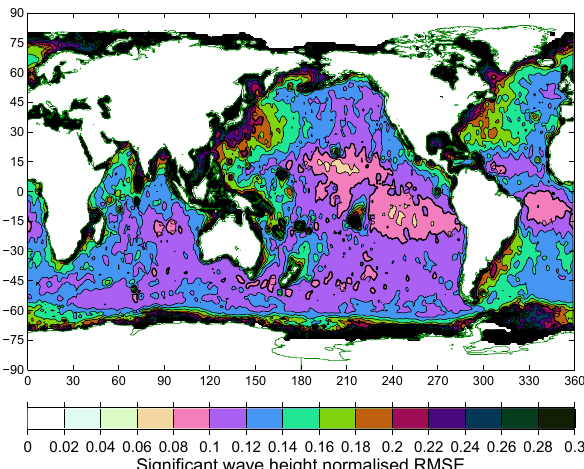
Figure 7. Normalised root mean square error in significant wave height from the hindcast compared with satellite altimeter measure- ments, over the period August 1991–December